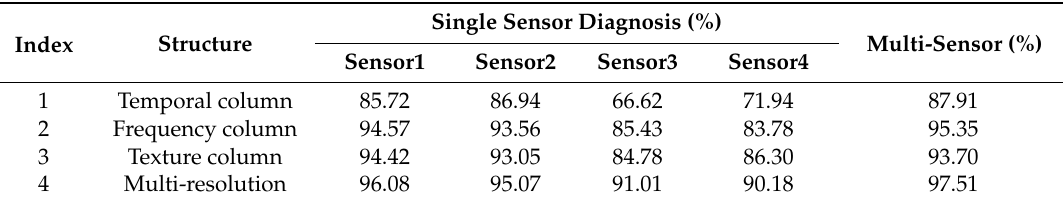
Table 3. Diagnostic accuracies and the intermediate outputs for classifying both the positions and defect types.